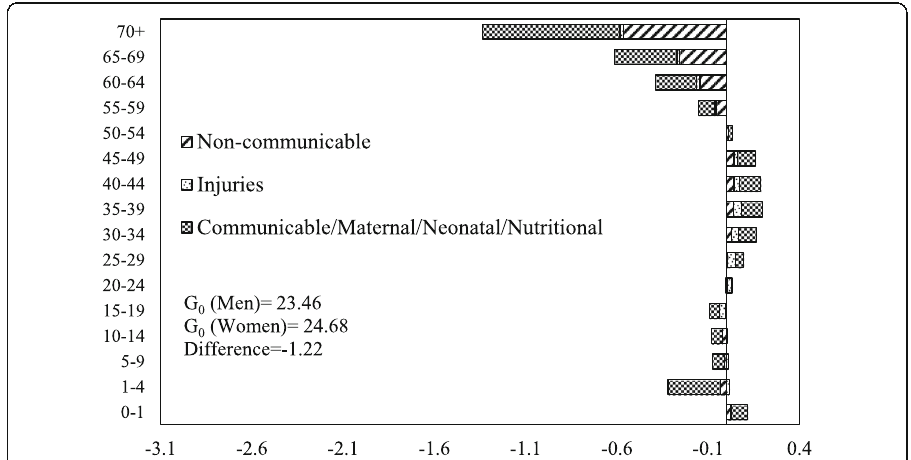
Fig. 6 Decomposition of the differences in Gini coefficient between men and women by age and cause